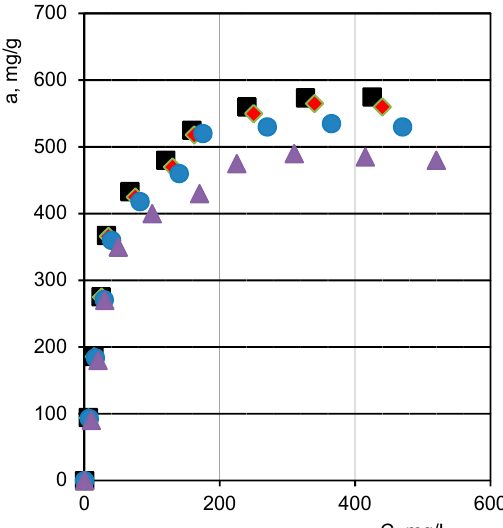
Figure 13. Diazepam adsorption isotherm on activated charcoal from simulated intestinal fluid (SIF) without and with ethanol pH = 6.80 ± 0.05; T = 37.0 ± 0.1 °C; ■ SIF without ethanol; ◆ SIF with 5% ethanol; • SIF with 10% ethanol; and ▲ SIF with 15% ethanol.